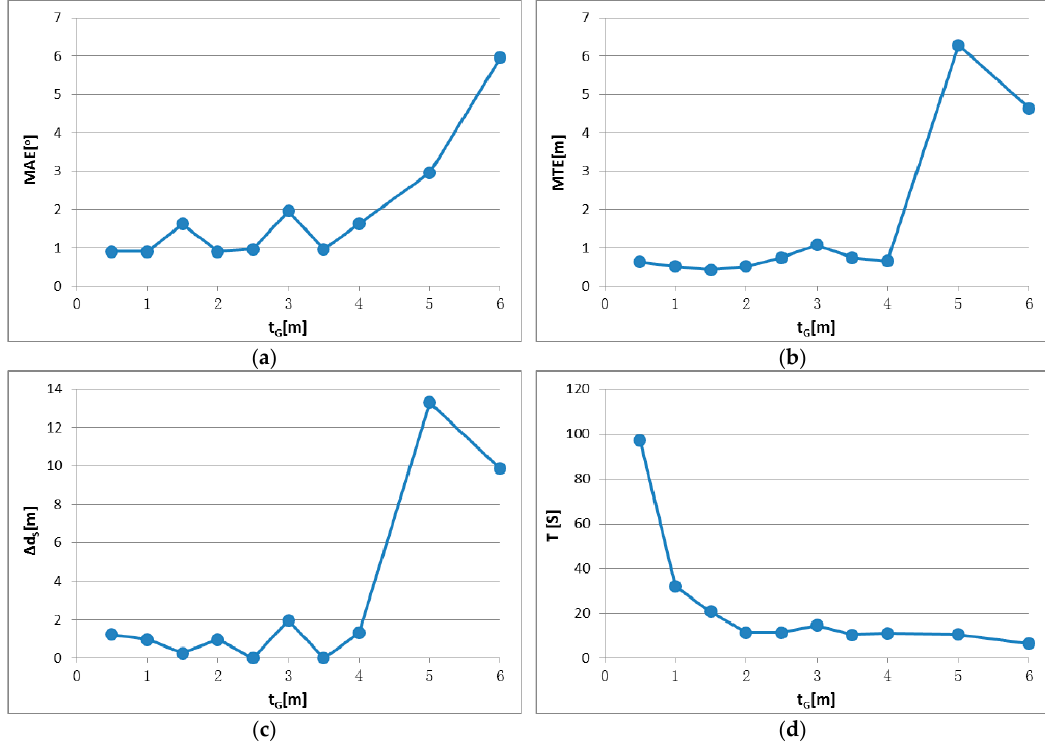
Figure 15. IME results with different t G when d G is fixed to 0.5 m: ( a ) mean angular error (MAE); ( b ) mean translation error (MTE); ( c ) scan distance error ( ∆ d S ); and ( d ) runtime (T).